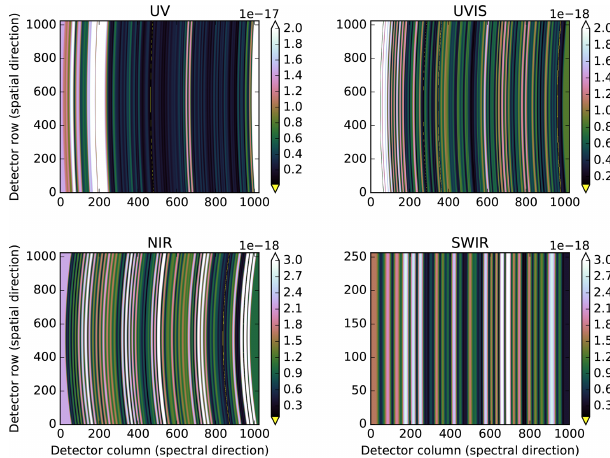
Figure 14. Pseudo-colour image of the ABSRAD CKD error, de- fined as the uncertainty in CKD pixel-to-pixel variation. The colour scale unit is (molm − 2 nm − 1 sr − 1 (e − ) − 1 ). The corresponding vari- [ x ] , is the square of this quantity. The wave-like ance, σ 2 det f absrad patterns observed in all detectors are an artefact of the spectral smoothing procedure. Note that this figure shows the final AB- SRAD CKD in which the ABSRAD result obtained for the optical axis row is duplicated to all remaining detector rows and the spectral smile is reapplied; RELRAD is not included